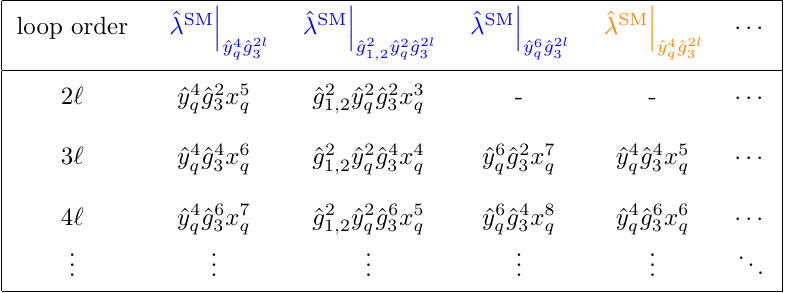
ˆ Table 3 . Contributions to λ SM of the highest (blue) and next-to-highest (orange) power in the x q parameter which exist at their respective order if parametrized by SM parameters. The orange terms have been given only for the choice ˆ A = ˆ y 4 . But corresponding structures for other terms q can be given